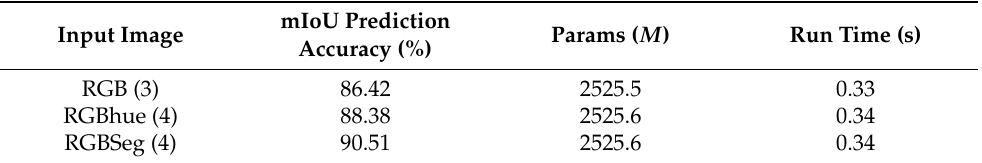
Table 16. Mean intersection of union (mIoU) prediction accuracy for different inputs for the Hyundai Motor Group (HMG) dataset.